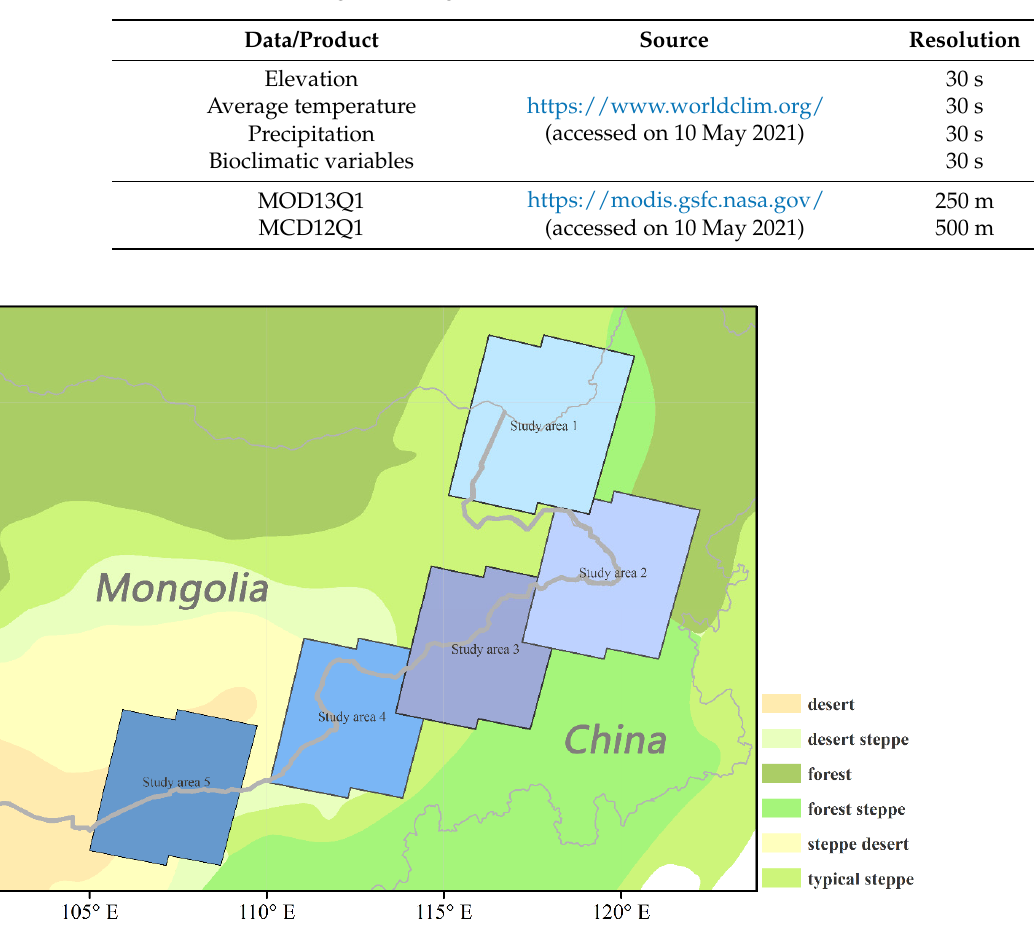
Table 1. Data for ecological zoning.